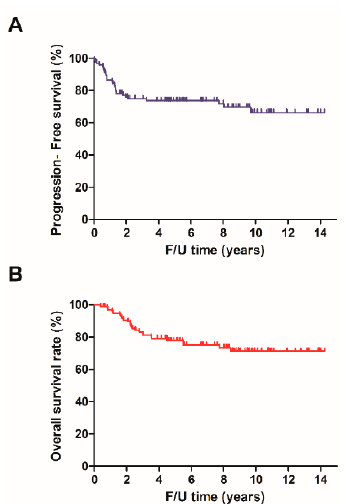
Figure 1. Disease-free survival ( A ) and overall survival ( B ). Figure 1. Disease ‐ free survival ( A ) and overall survival ( B ).